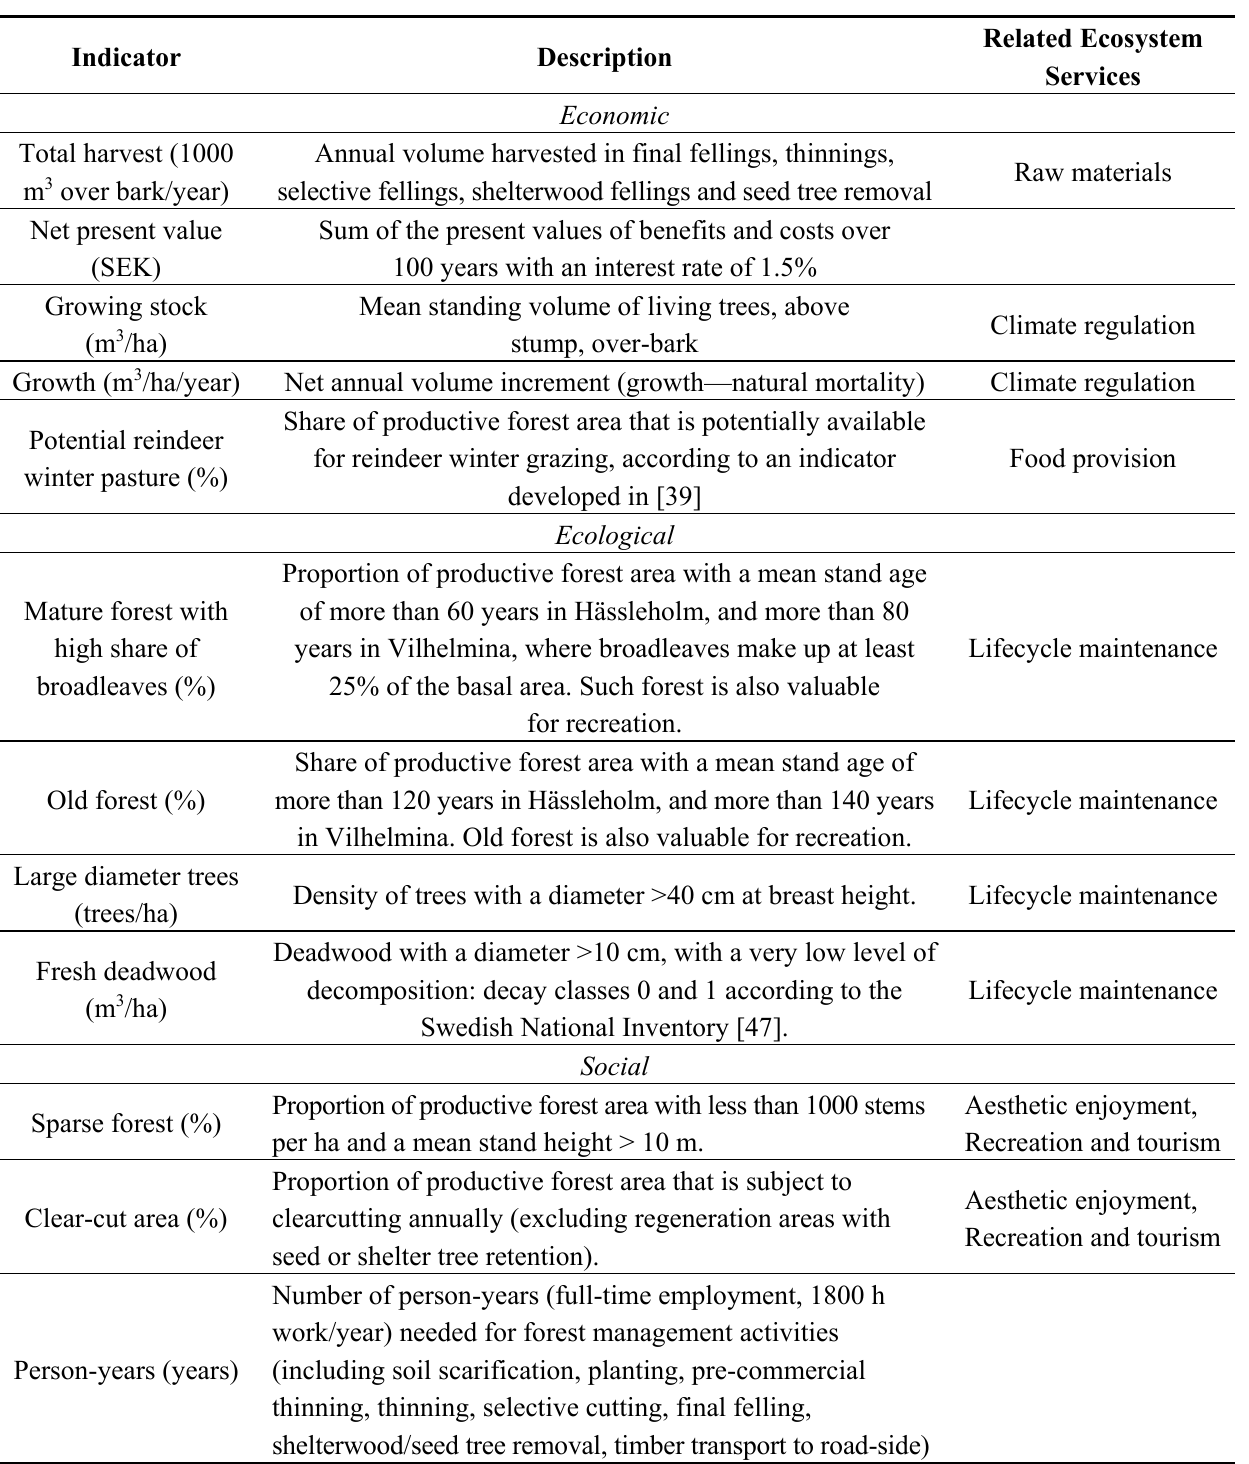
Table 8. Description of the indicators that were used to compare the Simple and Diverse